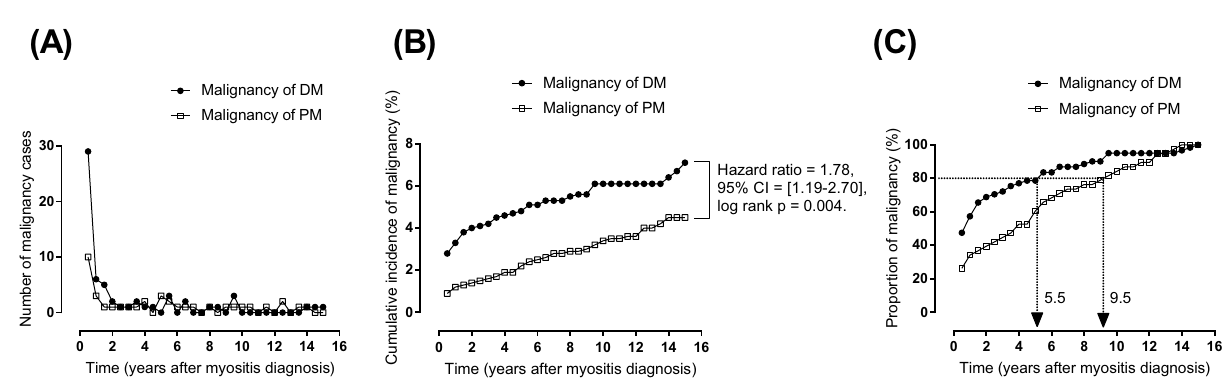
Figure 1. Case number ( A ), cumulative incidence ( B ) and the proportion of malignancy ( C ) in patients with DM and PM after initial diagnosis are plotted against the follow-up period in half-year intervals. The cumulative incidence showed a significant difference between patients with DM and PM based on Kaplan–Meier analysis (hazard ratio = 1.78, log-rank p value =